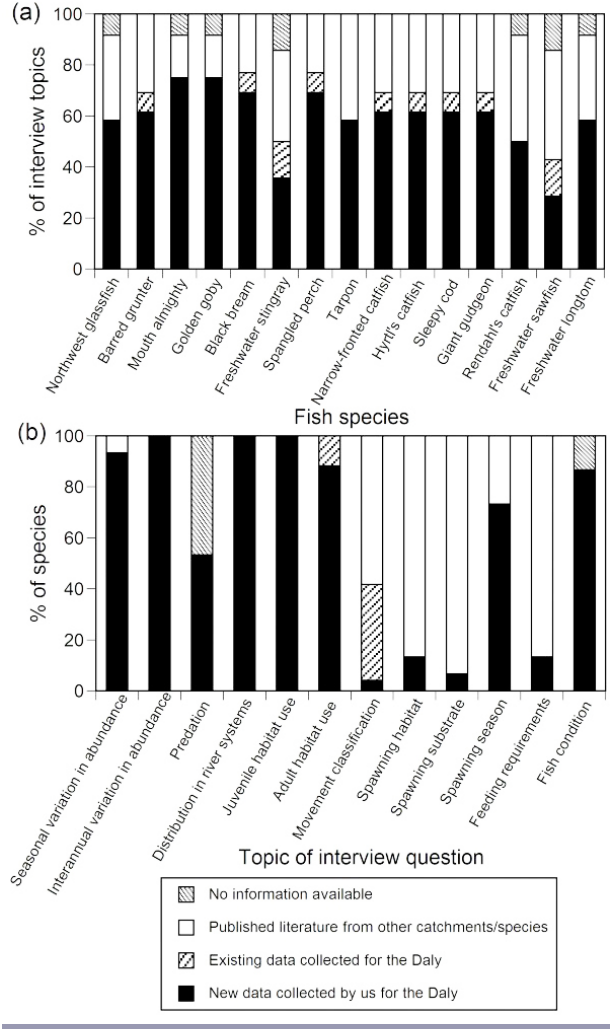
Fig. 2 . Summary of scientific knowledge sources by (a) fish species and (b) topic of interview questions relevant to environmental flow assessments of fish in the Daly River. Scientific knowledge sources were categorized as no information, published literature from other catchments or closely related species, existing data collected for the Daly River, and new data collected during this study. Information is summarized for (a) each fish species (% of responses to each of the 12 interview topics) and (b) each interview topic (% of responses for each of the 15 species).